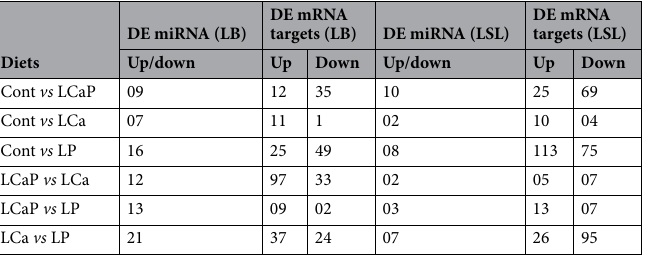
Table 2. The number of differentially expressed (DE) known miRNAs from comparisons between diet groups within strains (Lohmann Selected Leghorn (LSL) and Lohmann Brown (LB)) and their upregulated and downregulated target genes at cut-off of P < 0.05.